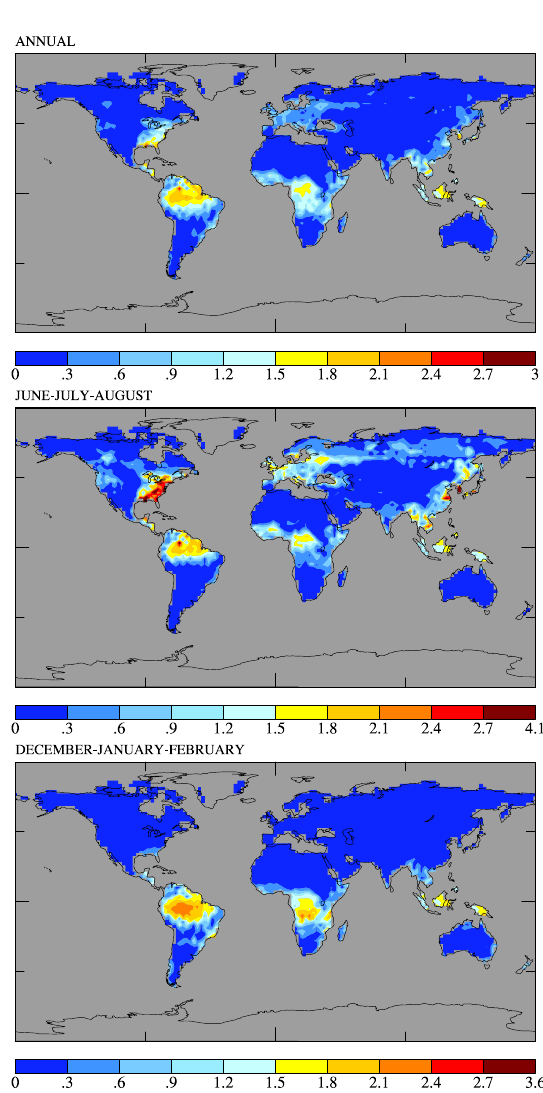
Fig. 1b. Spatial distribution of annual and seasonal average modeled isoprene emission in mgCm − 2 h − 1 in the control run